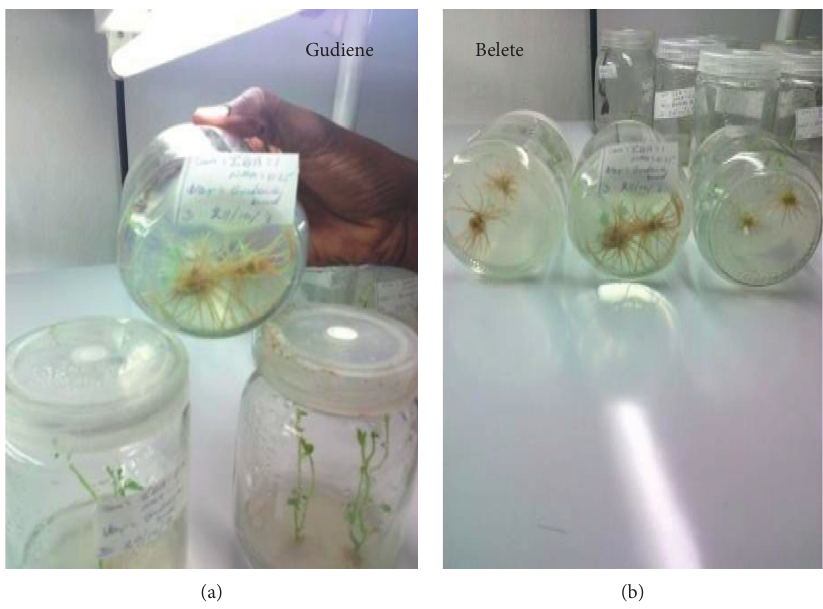
Figure 3: In vitro root formation in Gudiene and Belete varieties of